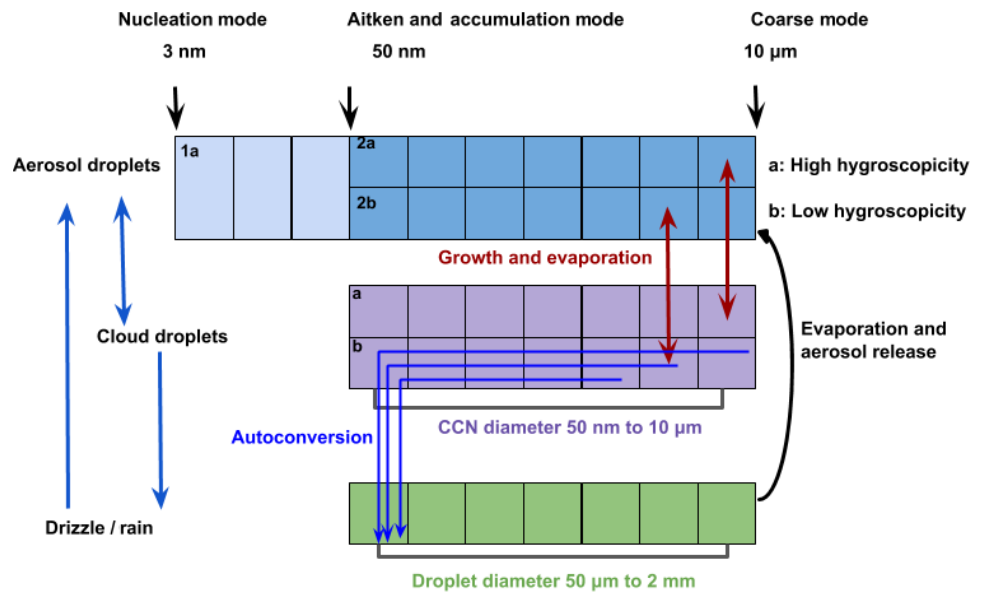
Figure 2. Schematic of the size bin layout for SALSA including the internal and external mixing size bins and the cloud and rain droplet bins (Tonttila et al.,